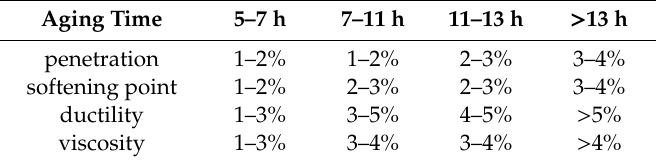
Table 3. E ff ect of di ff erent WEO contents on physical properties in di ff erent aged asphalts.